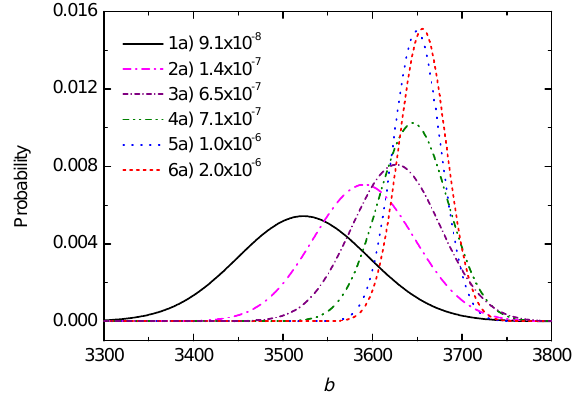
Fig. 14. Fitted normal distributions of b for the fraction frozen curves in Fig. 13. The values in the key are the median surface area per droplet of NX illite in cm 2 .